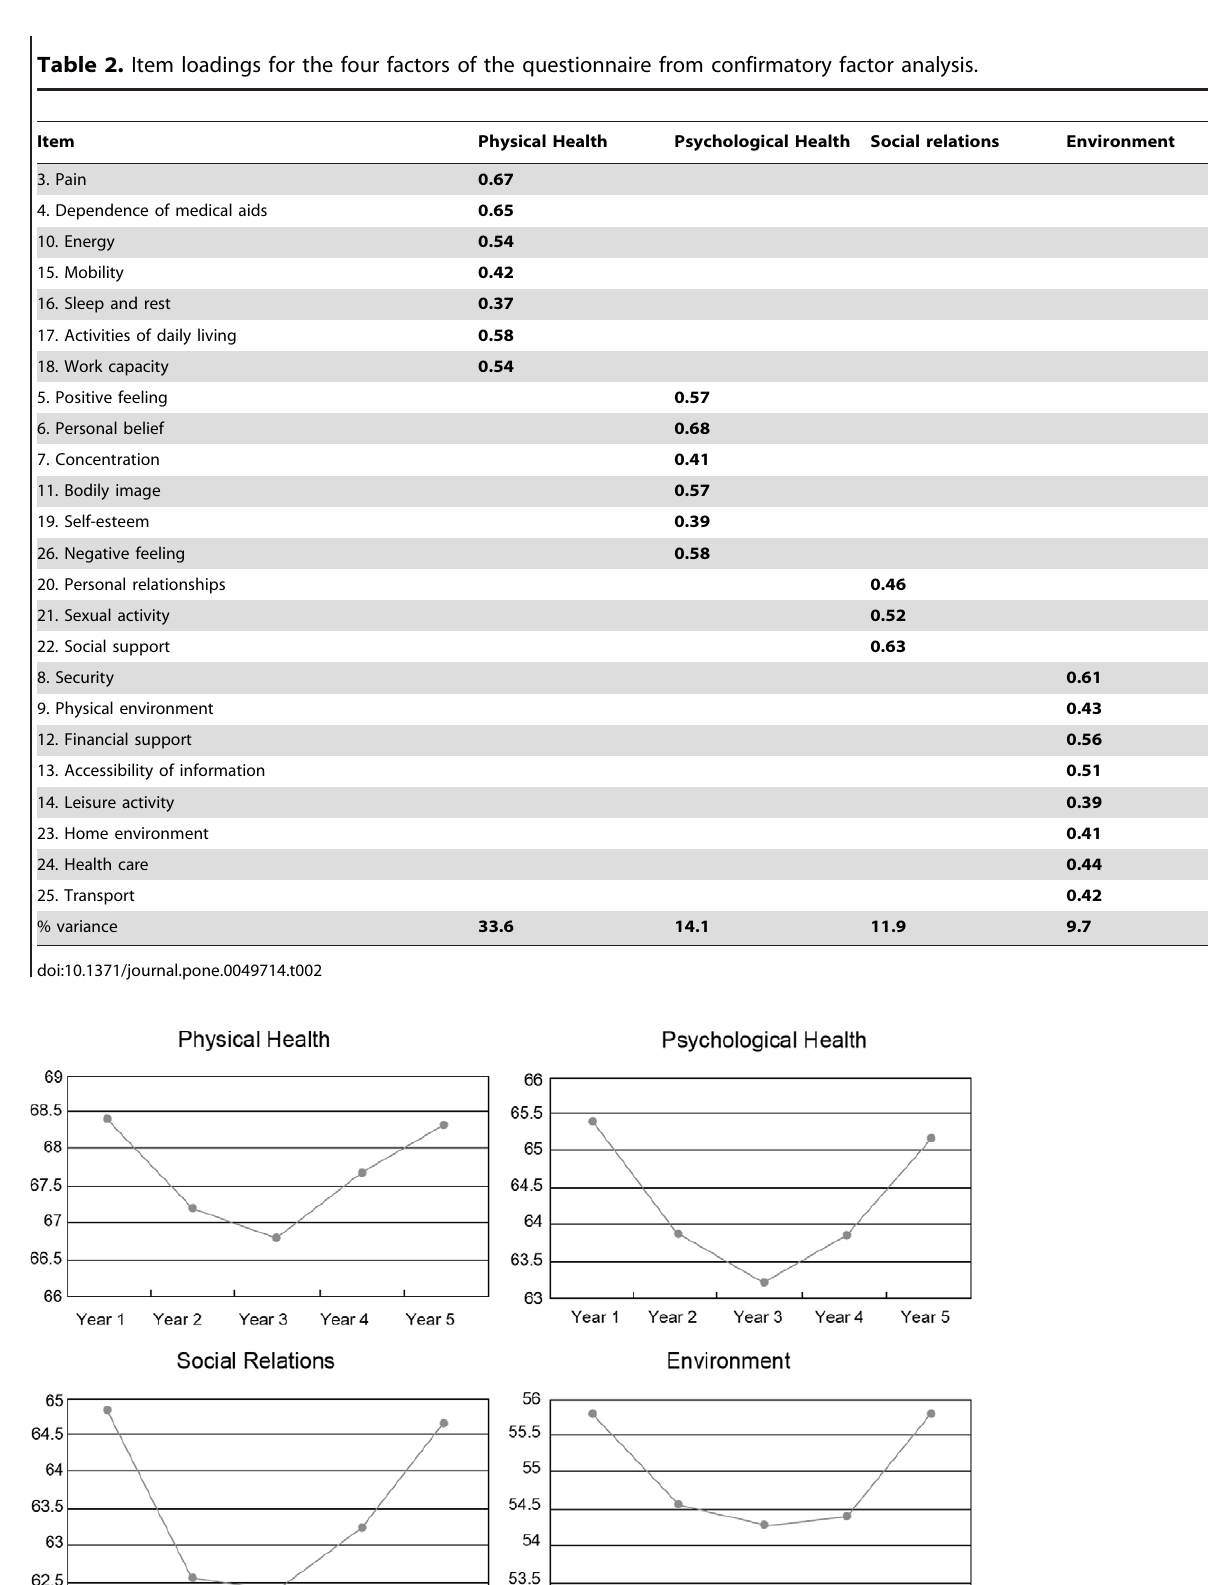
Table 2. Item loadings for the four factors of the questionnaire from confirmatory factor analysis.